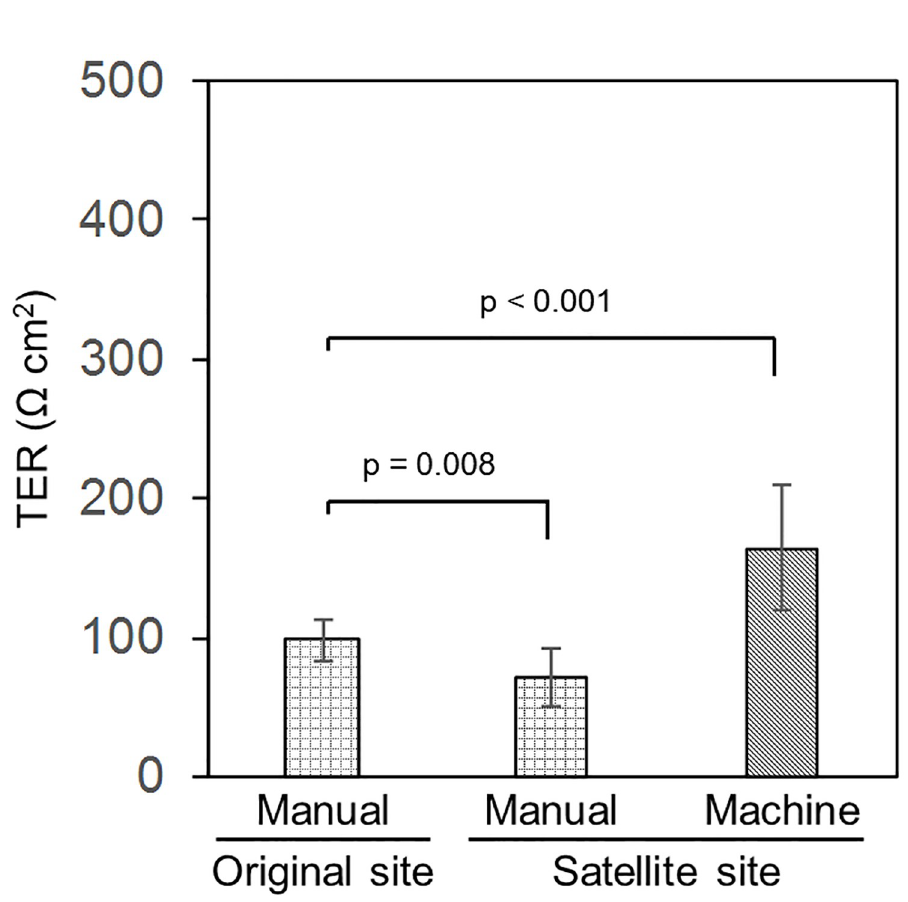
Fig 4. TER values of hiPS-RPE cell sheets cultured by machine and manually. hiPS-RPE cell sheets were cultured manually or using the automated ACE3 system and analyzed 49 days after seeding. The TER values of the hiPS-RPE cell sheets were calculated by subtracting the value of inserts covered with collagen gels as a blank from those of the experimental inserts. Data were obtained from two independent experiments. Machine cell culture, n = 9, manual cell culture, n = 7. All data are represented as the means ±